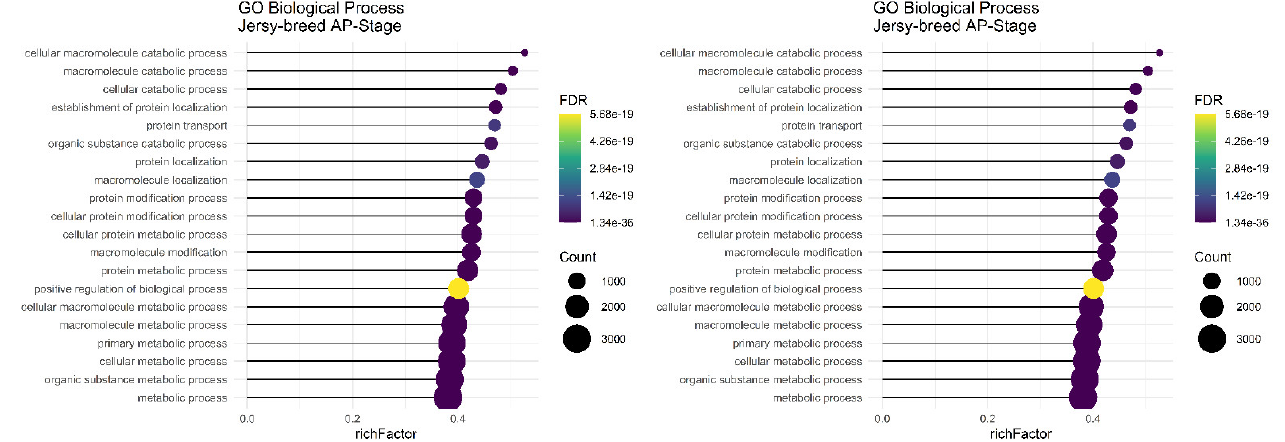
Figure 6. Functional enrichment analysis results of AP stage in Jersy and Kashmiri breeds. Since the significant biological process term is large, only 20 top significant terms are shown. The color and size of points indicate FDR and the number of genes associated with each term, respectively.